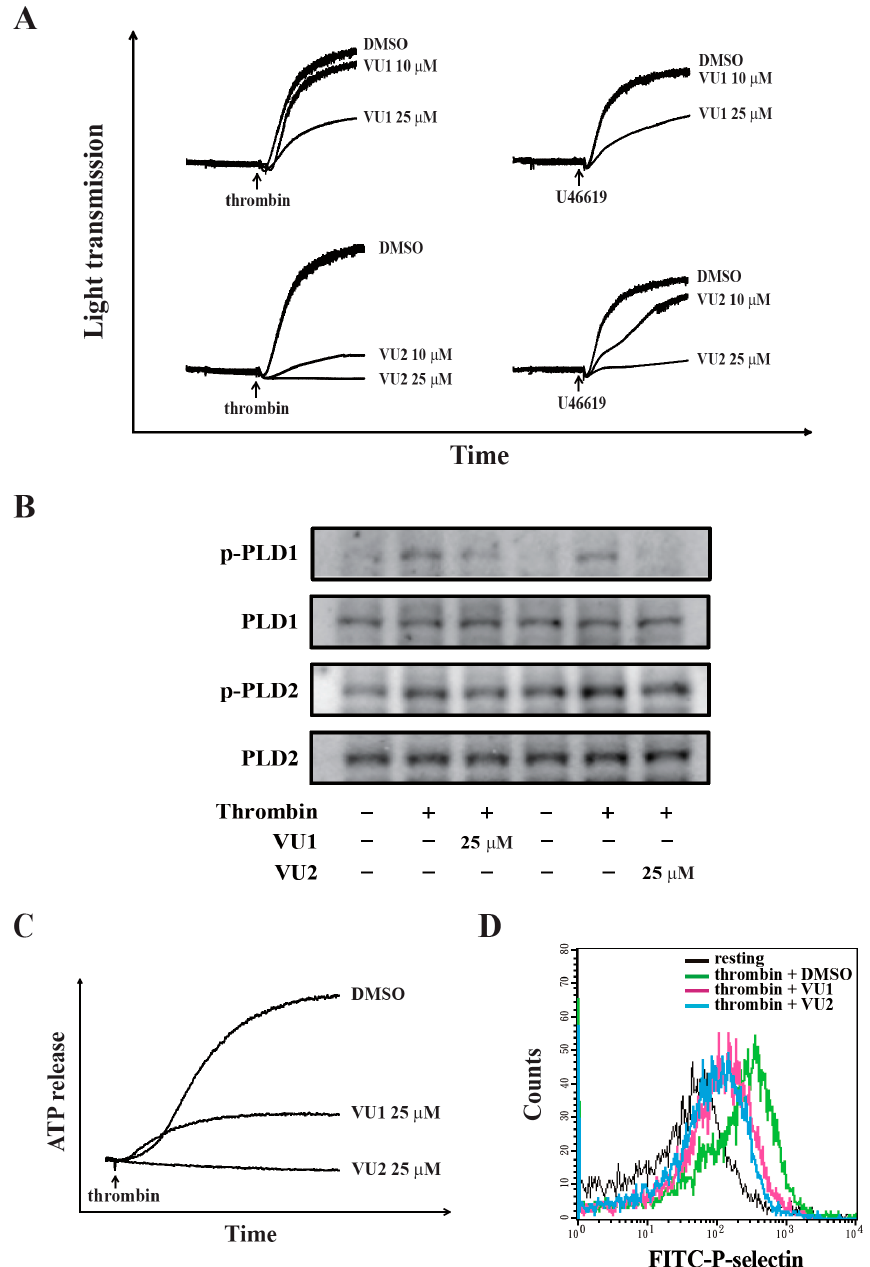
Figure 2. Pharmacological inhibition of PLD mediated the reduction of human platelet aggregation and granule release. ( A , B ) Washed human platelets (3.6 × 10 8 cells/mL) were preincubated with DMSO (solvent control), VU1 (10 and 25 µ M), or VU2 (10 and 25 µ M) and then stimulated using thrombin (0.01 U/mL) and U46619 (1 µ M) to trigger ( A ) platelet aggregation and the ( B ) phosphorylation of PLD1 and 2. Effects of VU1 (25 µ M) and VU2 (25 µ M) on ( C ) thrombin-induced adenosine triphosphate (ATP) release and ( D ) P-selectin secretion were characterized by the detection of chemiluminescent emission from the luciferin–luciferase reaction and the fluorescence of P-selectin–fluorescein isothiocyanate (FITC)–antibody through flow cytometry, respectively. The profiles ( A – D ) are representative examples of three similar experiments.